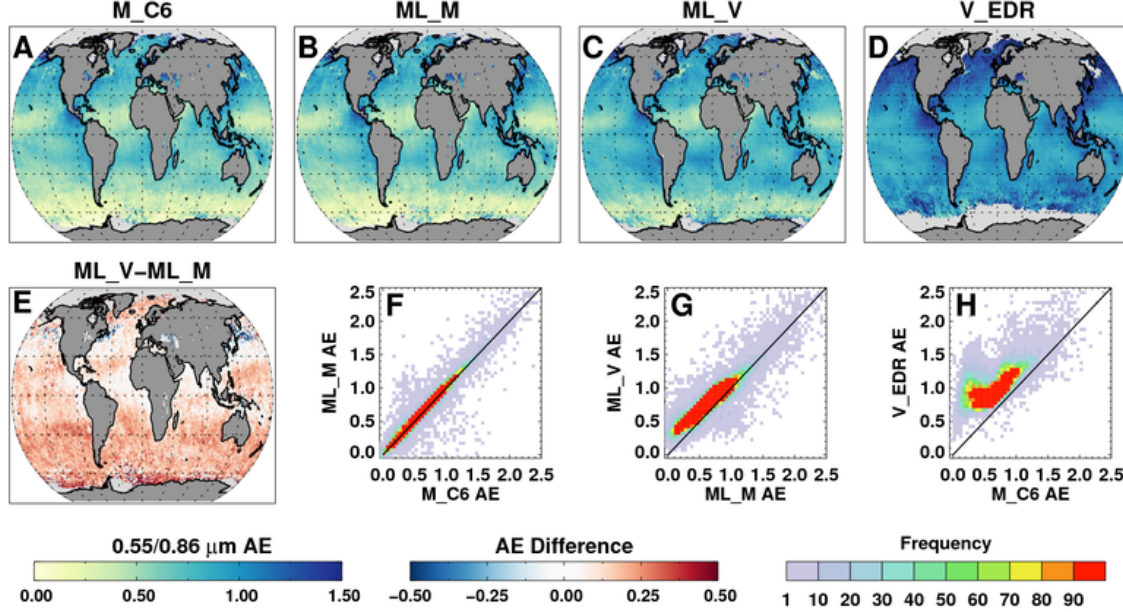
Figure 13. Spring 2013 (March–April–May) maps (1 ◦ × 1 ◦ ) of QA-filtered AE (0.55/0.86µm), derived from spectral AOD retrieved from the MODIS Collection 6 (a) , MODIS-like algorithm on MODIS (b) and VIIRS (c) IFF, as well as on the V_EDR (d) . (e) is the difference between the two ML data sets. (f–h) are scatterplots comparing gridded AE from the different data